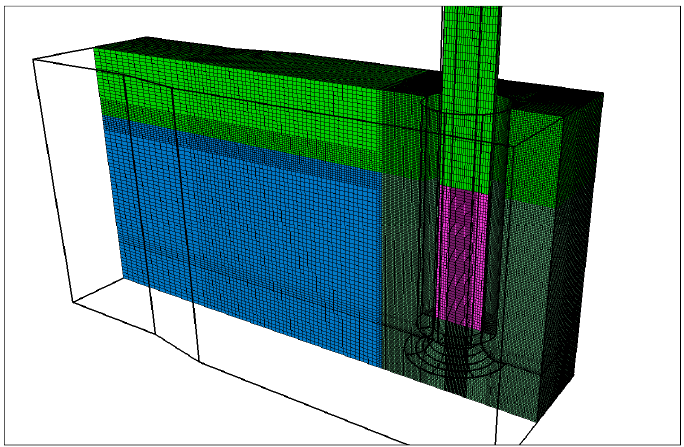
Figure 4. Cutaway view of the meshed model showing 4 regions with varying mesh densities to reduce calculation time.